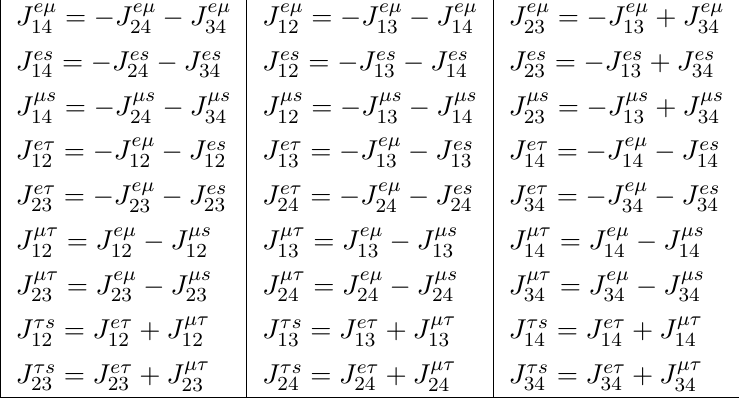
Table 2 . Expressions of other 27 Jarlskog invariants in terms of chosen bases in eq.